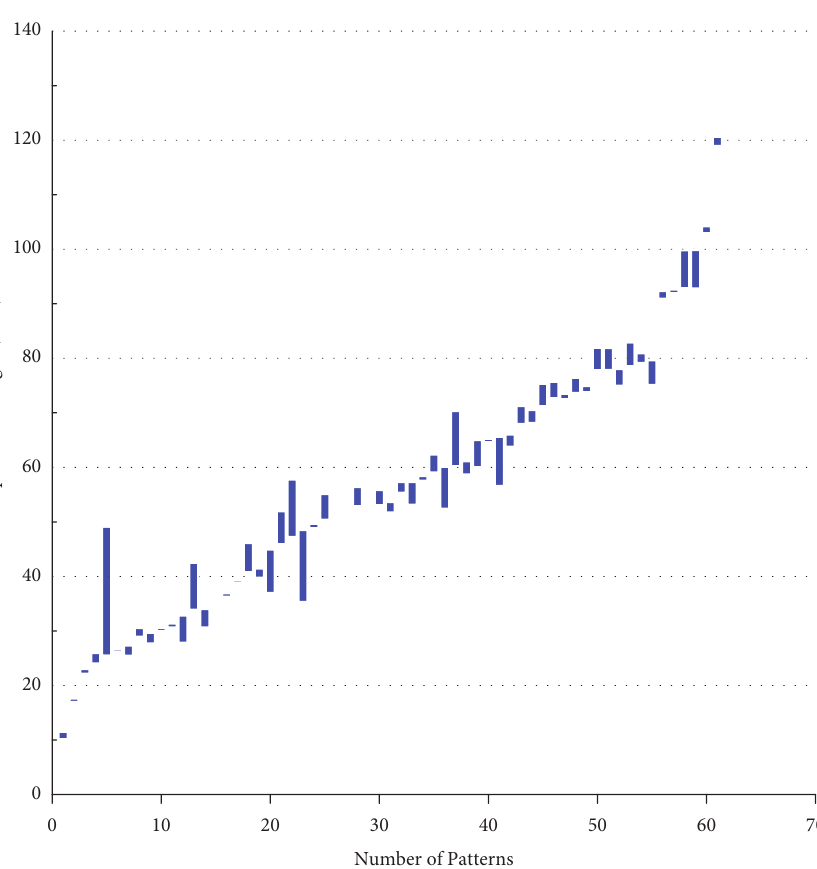
Figure 9: Floating bar chart of errors of ANN-GWO (7-13) model using testing